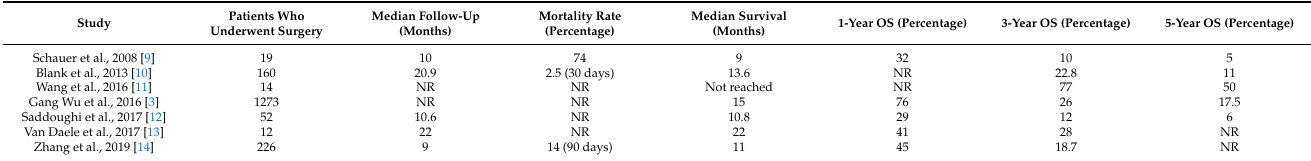
Table 5. Oncological follow-up and survival